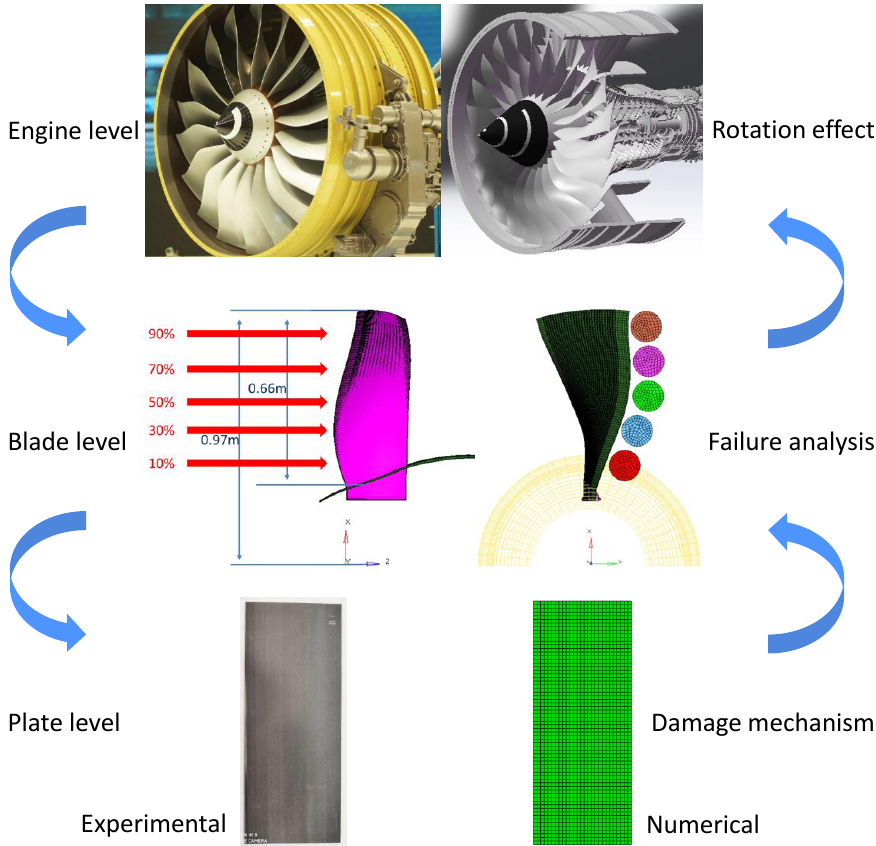
Figure 1. The role of plate-level study for bird-strike analysis of aeroengine fan blade.